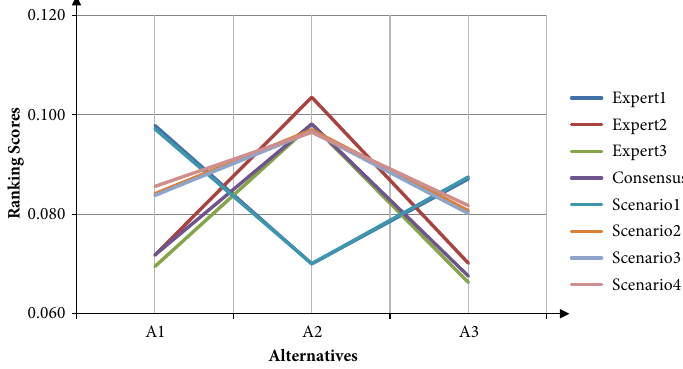
Fig. 4. Ranking scores for alternatives obtained by Fuzzy TOPSIS with respect to the expert preferences and weighting scenarios.